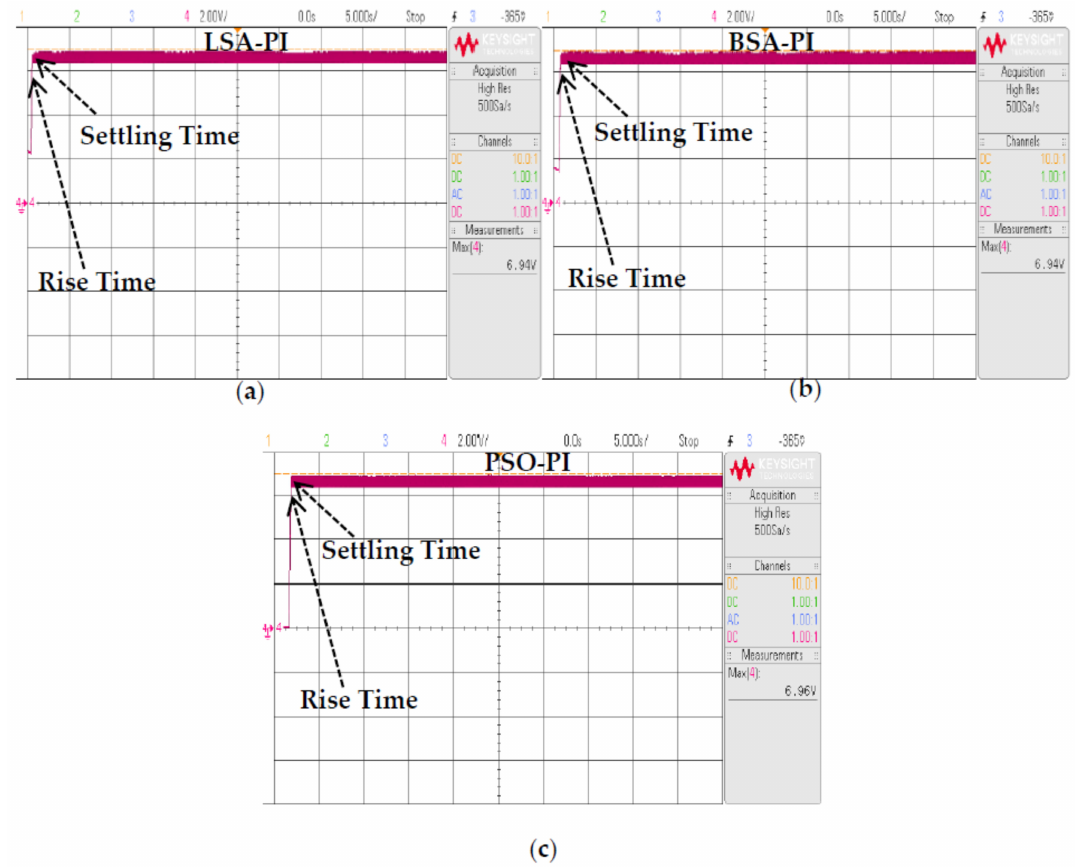
Figure 17. Experimental output LSA-PI ( a ), BSA-PI; ( b ) PSO-PI; ( c ) controllers considering rising and settling